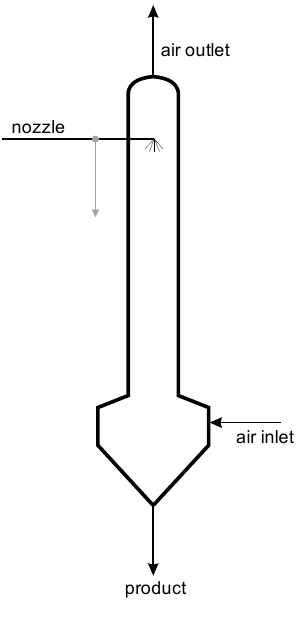
Figure 2. Counter-current spray drying tower. The position of the nozzle in the tower was changed against the distance of the air inlet, which allowed analyses of the effect of nozzle location on drying and agglomeration. The nozzle was installed in three different positions from the air inlet: 2.4 m, 4.7 m, and 6.7 m. Figure 3 shows a comparison of average particle diameters along the drying tower for three different nozzle locations and different process parameters; the final average diameter of agglomerates changed from 150 to 450 µ m. The most intensive agglomeration and the highest average particle growth was observed when the nozzle was installed at 4.7 m and 6.7 m from the air inlet.